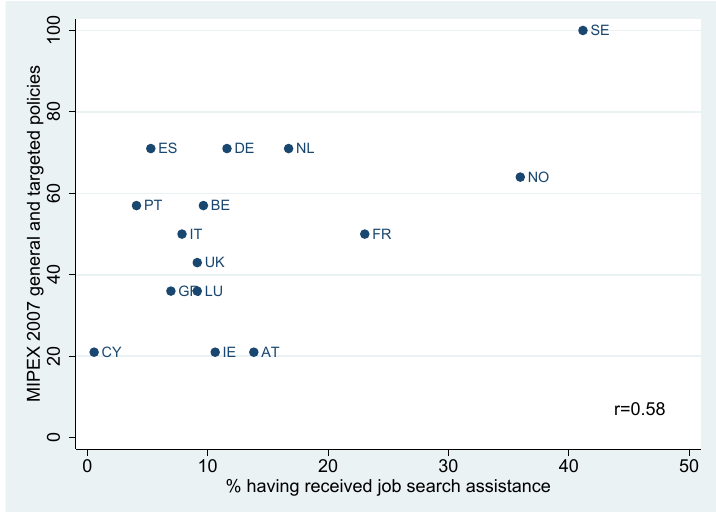
Figure 5: Proportion of immigrants who received labor market counseling and countries’ MIPEX of labor market mobility, access to general and targeted support.